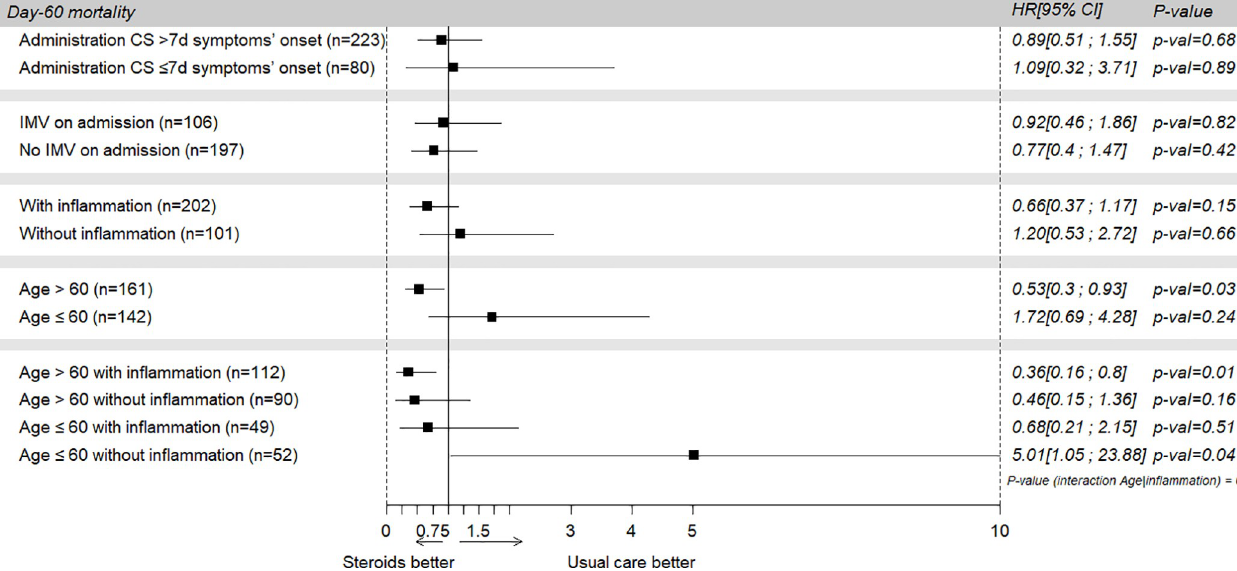
Fig 3. Effect of corticosteroids on ICU death in different subgroups. CS: Corticosteroids; IMV: Invasive mechanical ventilation; HR: Hazard Ratio; CI: Confidence Interval. https://doi.org/10.1371/journal.pone.0255644.g003 episode of ICU-BSI: 13 (19.7%) vs. 30 (19.7%) (p = 0.15), and at least one episode of HAP- VAP: 25 (37.9%) vs. 70 (29.5%) (p = 0.20), respectively. After weighted Fine & Gray subdistribution survival model analyses, the risk of ICU-BSI and the risk of HAP-VAP at day 60 did not differ between patients with and without early CS therapy (SubHRw = 1.01 for ICU-BSI, CI 95% 0.55 to 1.85, p = 0.97 and SubHRw = 1.19 for HAP-VAP, CI 95% 0.74 to 1.92, p = 0.42, respectively) (Fig 2 and S6 and S7 Tables).